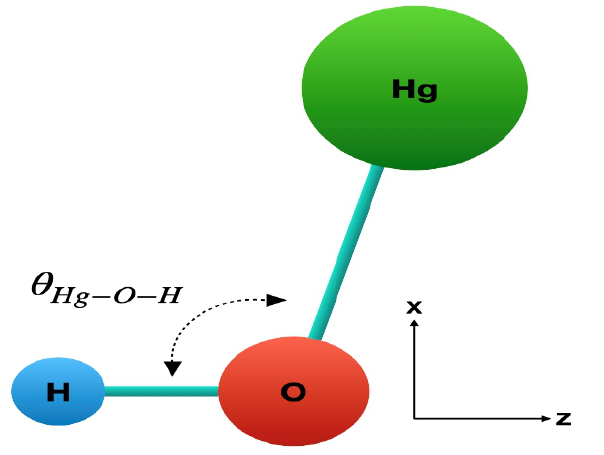
Figure 1. Pictorial representation of the bent geometry of the ground state of HgOH. Our finding shows θ Hg − O − H = 104.83 ◦